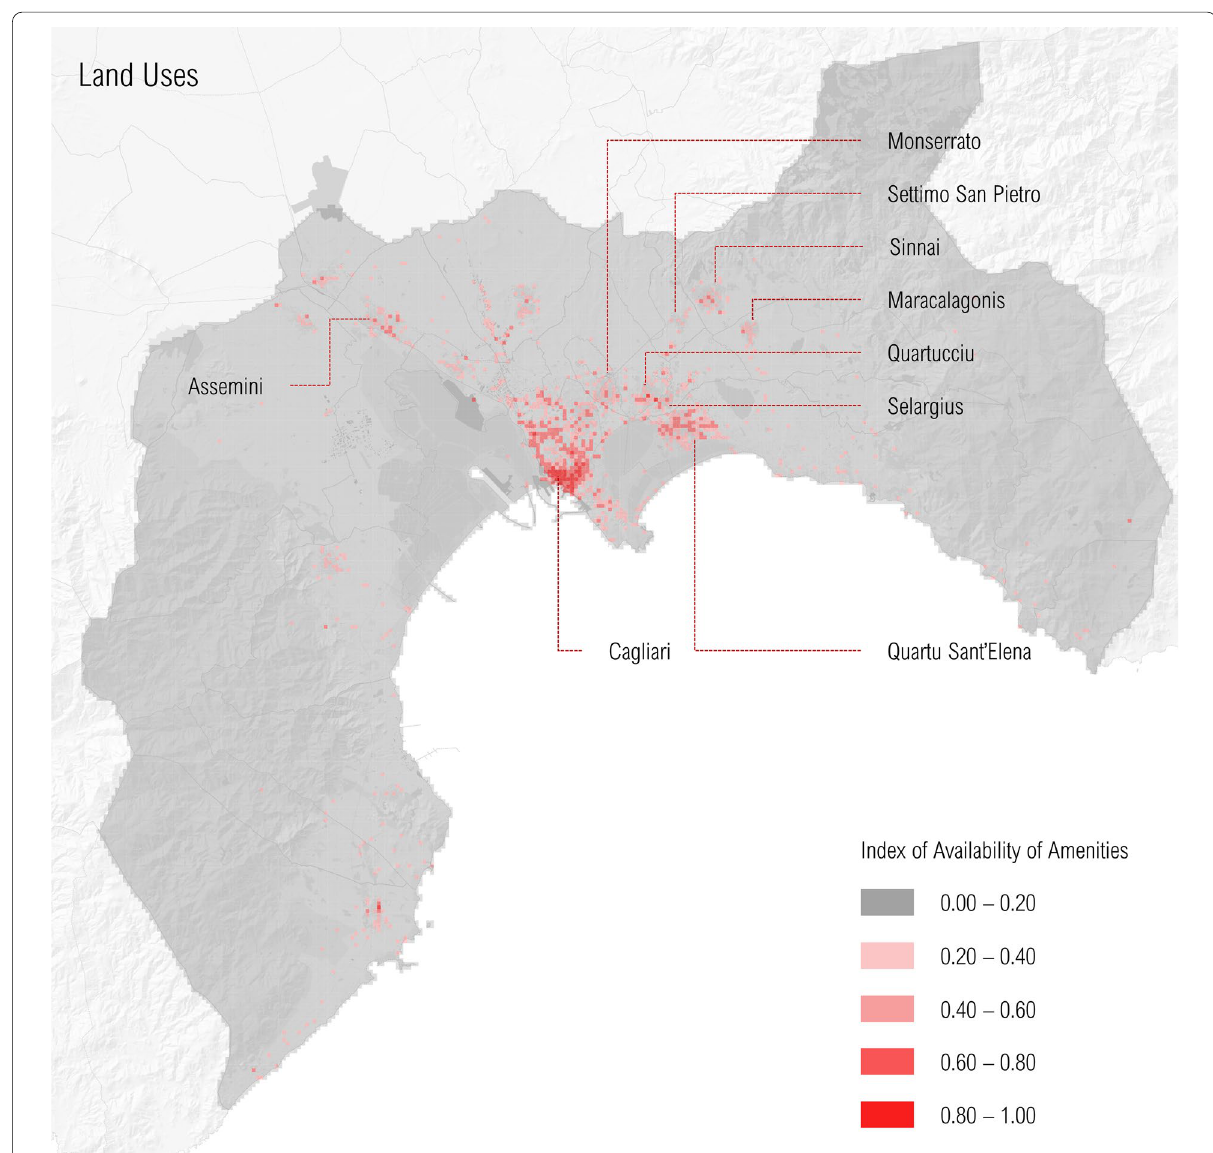
Fig. 9 Distribution of the values of the Index of Availability of Amenities (I_LU) across the the Metropolitan City of